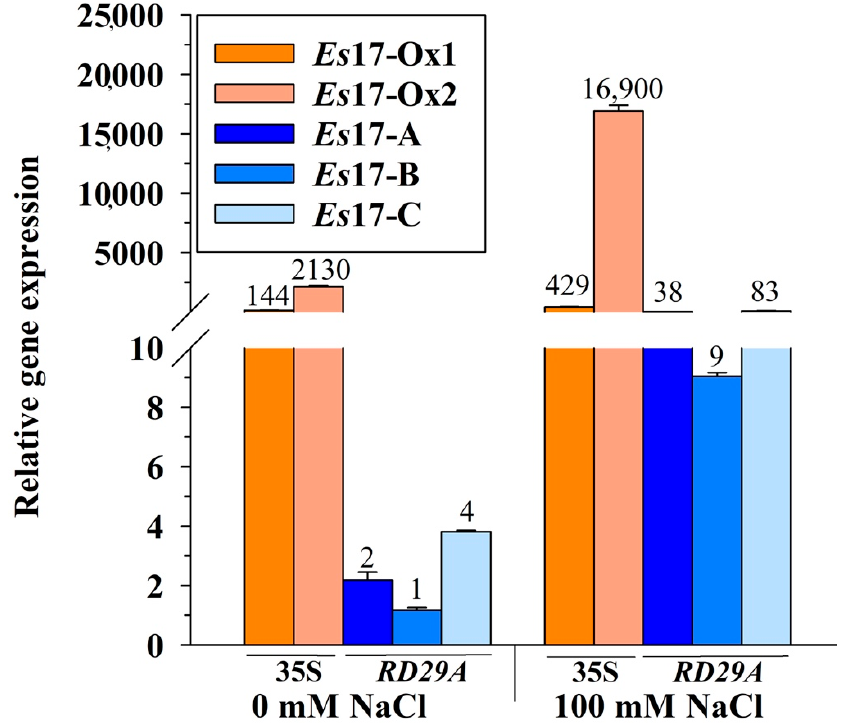
Figure 2. Expression of Esi0017_0056 in two independent A. thaliana transgenic lines having the 35S promoter and in three independent transgenic lines having the stress inducible (RD29A) promoter under standard and salinity stress conditions. Actin was used as the endogenous control and transcript levels were normalized to the individual with the lowest expression from line Es 17-B. Data represent mean ± SE from 3 biological replicates. Values listed on the bars represent relative expression, fold change ratio vs the line with the lowest Esi0017_0056 expression, that is, line Es 17-B in absence of NaCl.